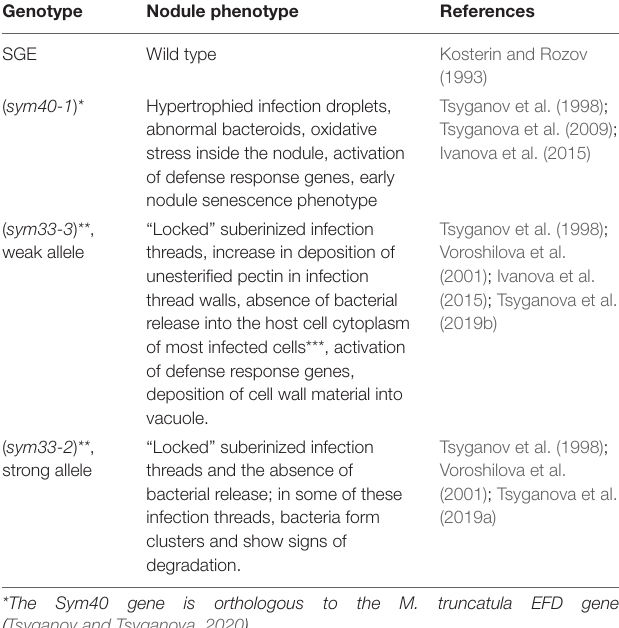
TABLE 1 | Plant material used in the